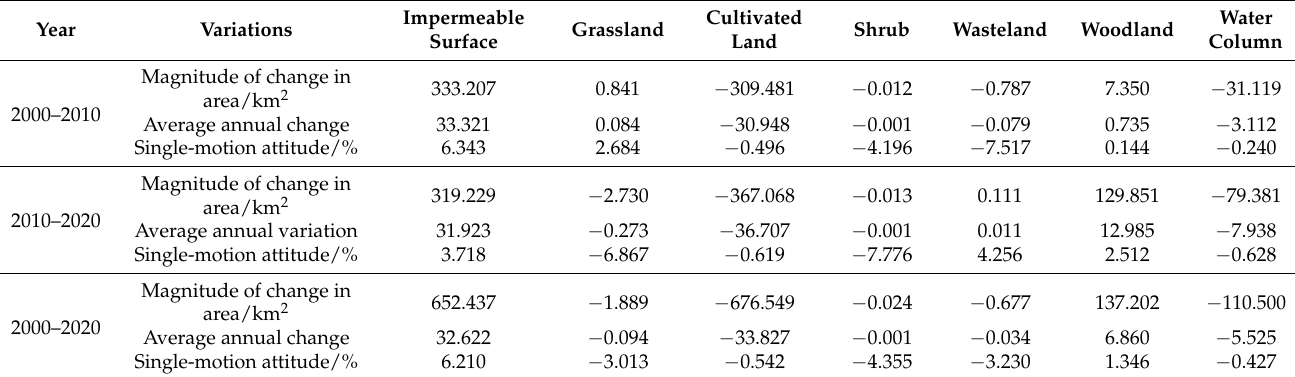
Table 11. Changes in land-use types in Wuhan,